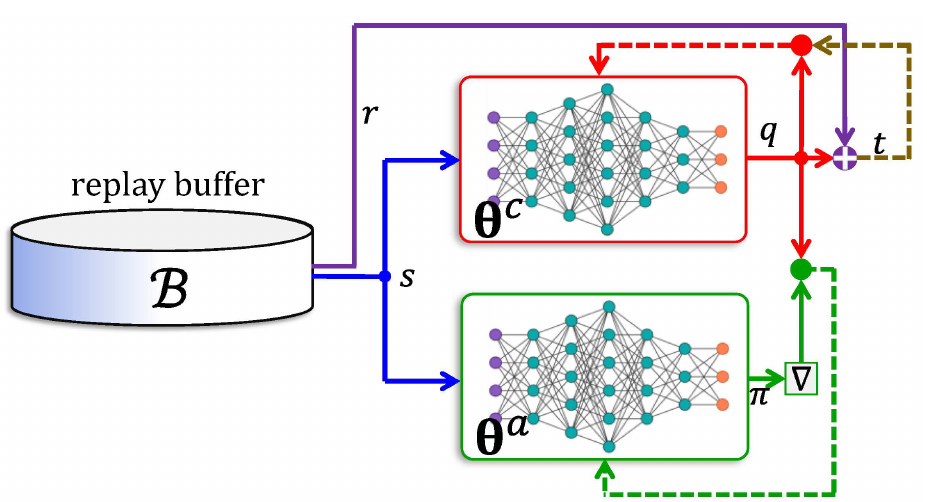
Figure 11. Actor–Critic Network. Shown is the overall schematic used in actor–critic learning, comprising of an actor DNN and a critic